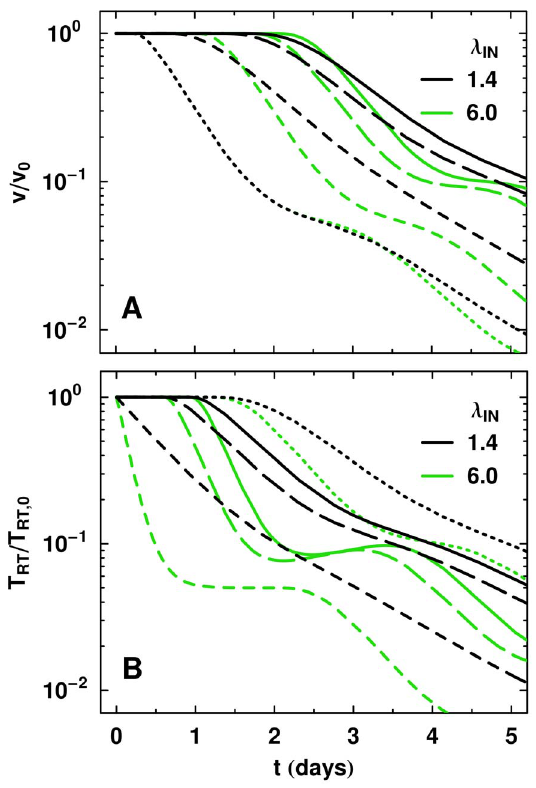
Figure 7. Influence of the progression rate to IN, l IN , on the pVL curves. (A) A relatively low rate of l IN ~ 1 : 4 day { 1 (black curves) giving a variance of 0.5 days around the mean time to IN D t IN , leads to a large slope difference between the INI and RTI, compared to a fast rate l IN ~ 6 : 0 day { 1 (gray curves) with standard deviation of 0.1 days around the mean for virus progressing from the middle of RT to IN. (B) In this panel, we show how the CD4 + T cells move from RT to IN for all drug classes. For l IN ~ 1 : 4 day { 1 , note the relatively slow rate at which the T RT progress from the RT stage and move to IN, is reflected in the slow decrease in T RT . An efficacy of 0.95 is used for each